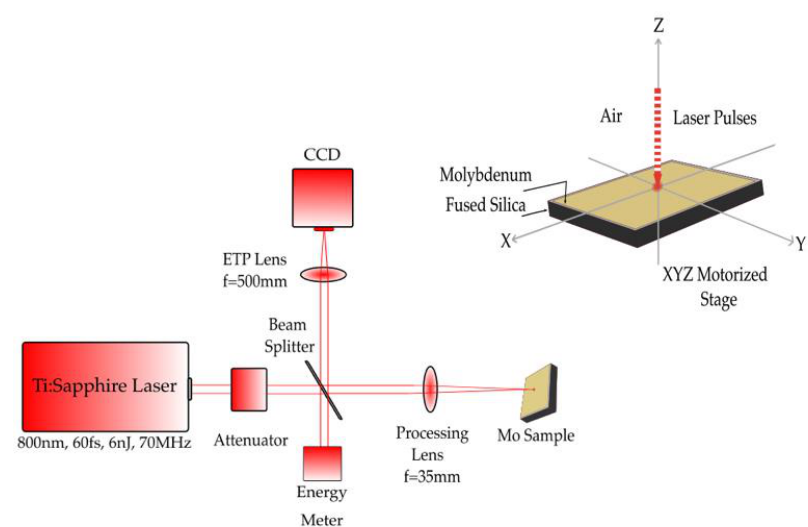
Figure 1. Experimental set up. The Ti:Sapphire linearly polarized laser beam is focused down on to the Mo sample by a 35 mm focal length processing lens. The laser pulse energy is adjusted by using an attenuator made of a half-wave plate and a linear polarizer. The ETP 500 mm focal length lens together with the CCD camera, and the 35 mm processing lens, make an image relay optical system for visualizing the target (Mo sample) plane.